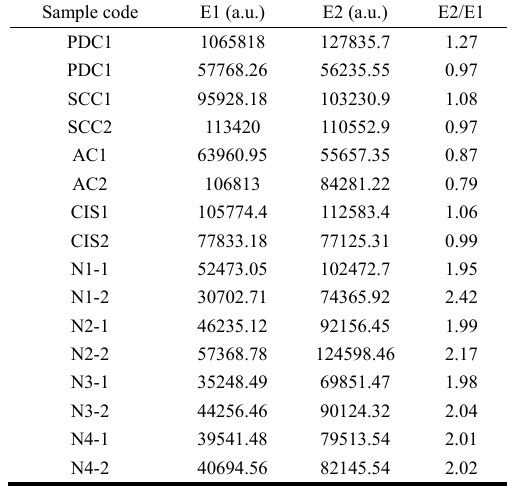
Table 2 Ratios of the integral energies of two Raman spectrum bands.